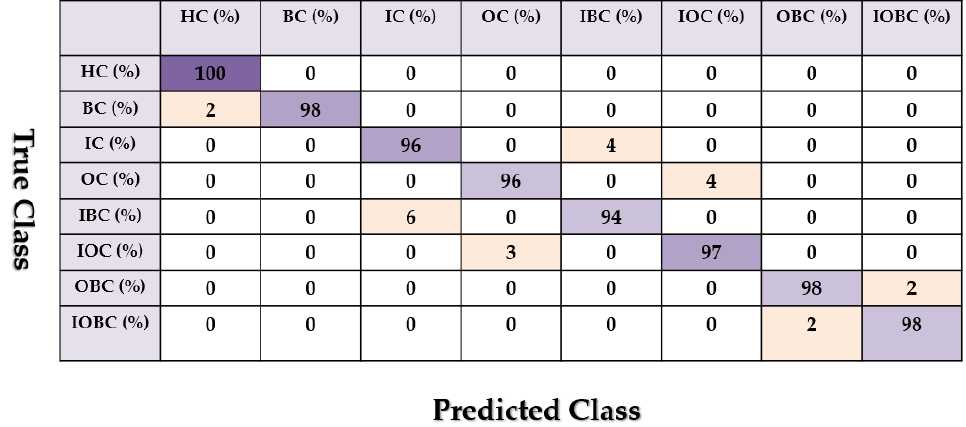
Figure 15. The average of crack type diagnosis using the combination of the PDT and SVM ap- proaches.